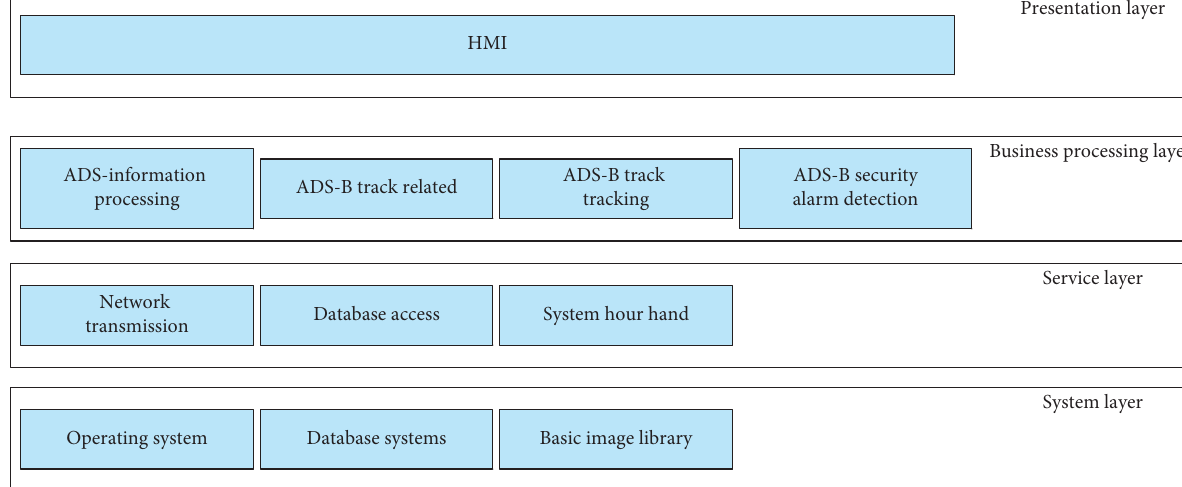
Figure 10: Hierarchical structure diagram.